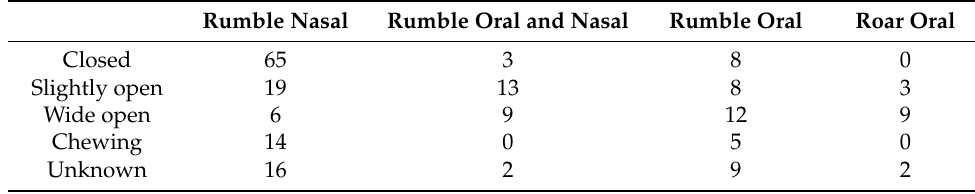
Table 4. Mouth opening defined by visual jaw lowering during call